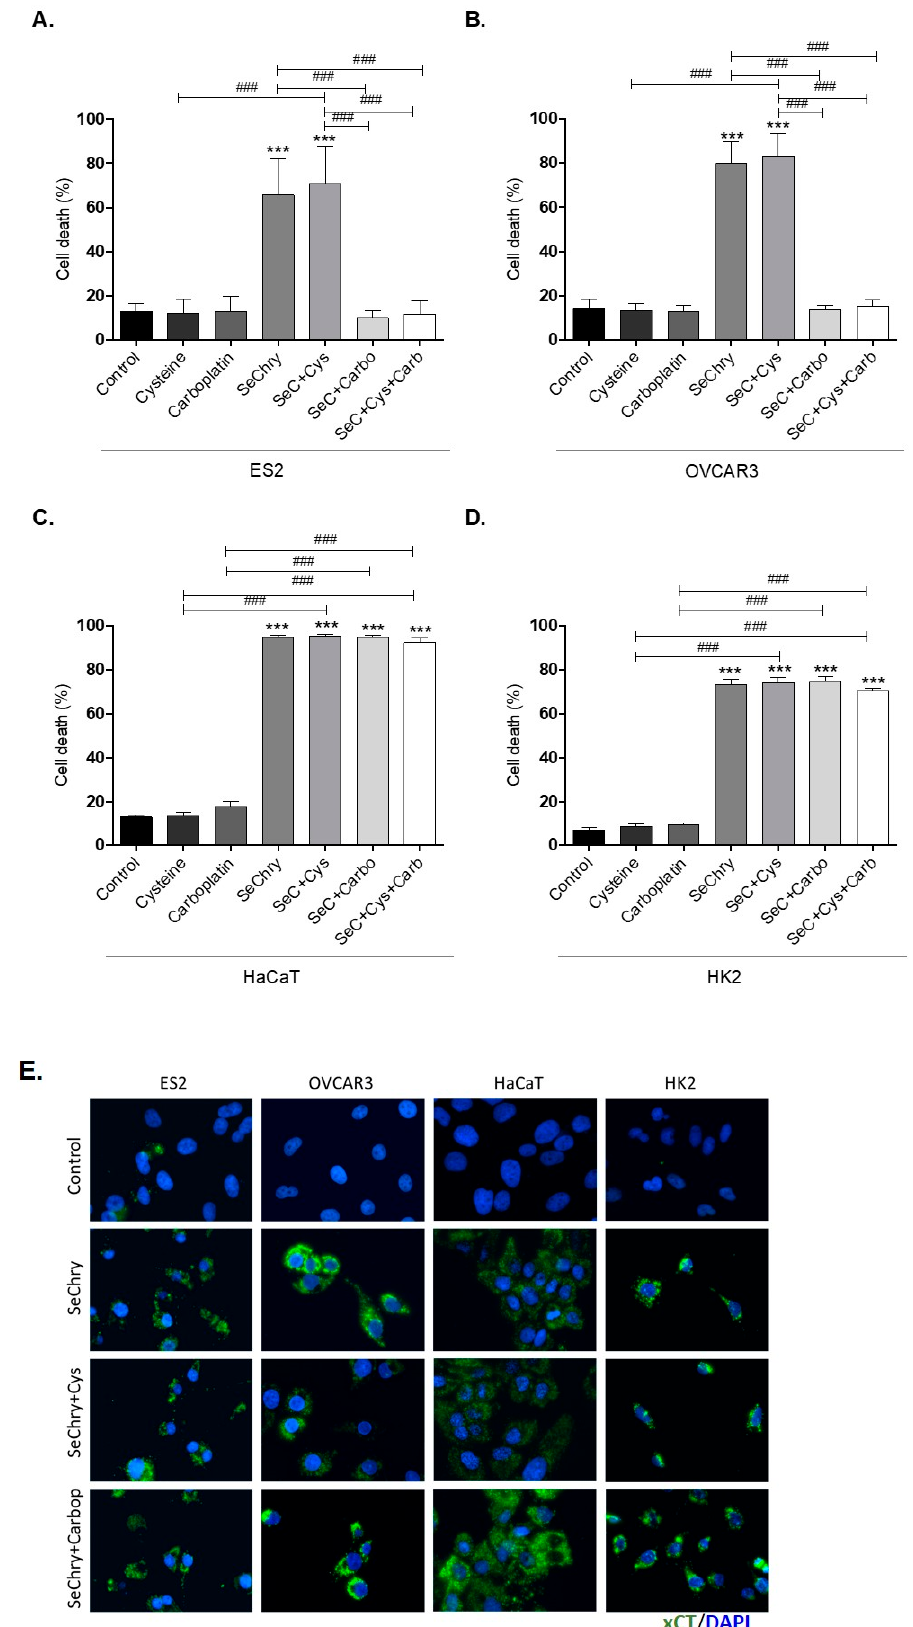
10 Figure 2. Selenium–chrysin (SeChry) induces cell death and xCT expression. All cell lines (ES2, OVCAR3,